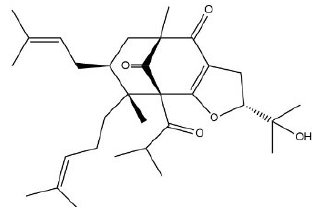
Figure 1. The structure of hypermongone C, a polycyclic polyprenylated acylphloroglucinol.